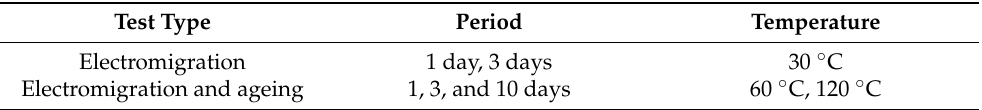
Table 1. Test Conditions of the